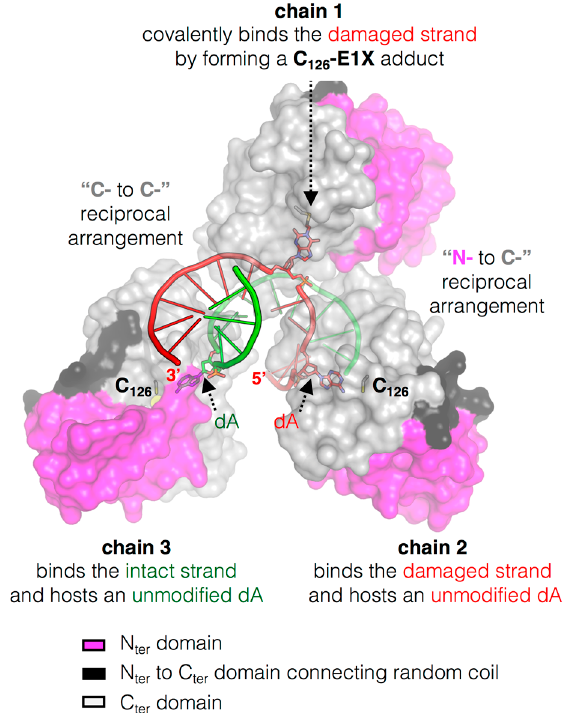
Figure 3. The peculiar cluster of Mt OGT. Surface representation of three Mt OGT units on an E1X-dsDNA which behaves as a mechanistic inhibitor of the protein (PDB ID: 4WX9); the two protein domains are depicted with different colors as indicated in the figure, the dsDNA molecule is rendered as cartoon and the extra-helical bases are rendered as sticks (adapted from [45]).